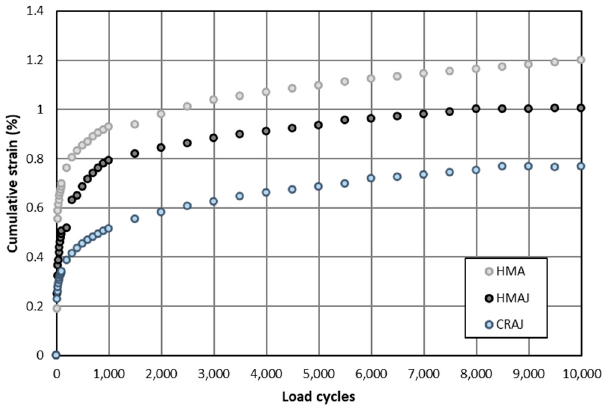
Figure 19. Cumulative strain vs. load cycles.